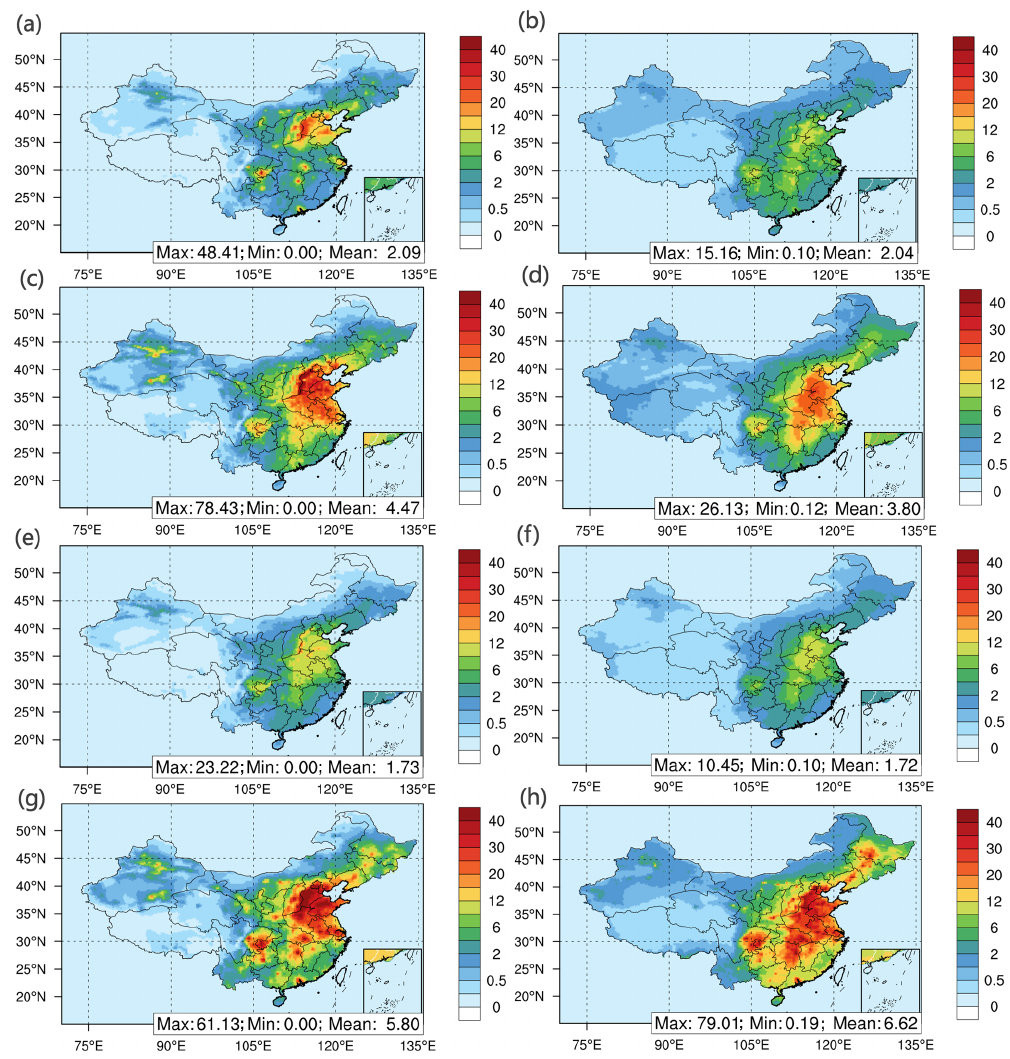
Figure 5. The spatial pattern of PM 2 . 5 compositions modeled by the InMAP-China and WRF-CMAQ models. Panels (a) , (c) , (e) and (g) present the respective sulfate, nitrate, ammonium and primary PM 2 . 5 simulated by InMAP-China in the InMAP-TOT scenario. Panels (b) , (d) , (f) and (h) present the corresponding results modeled by WRF-CMAQ.